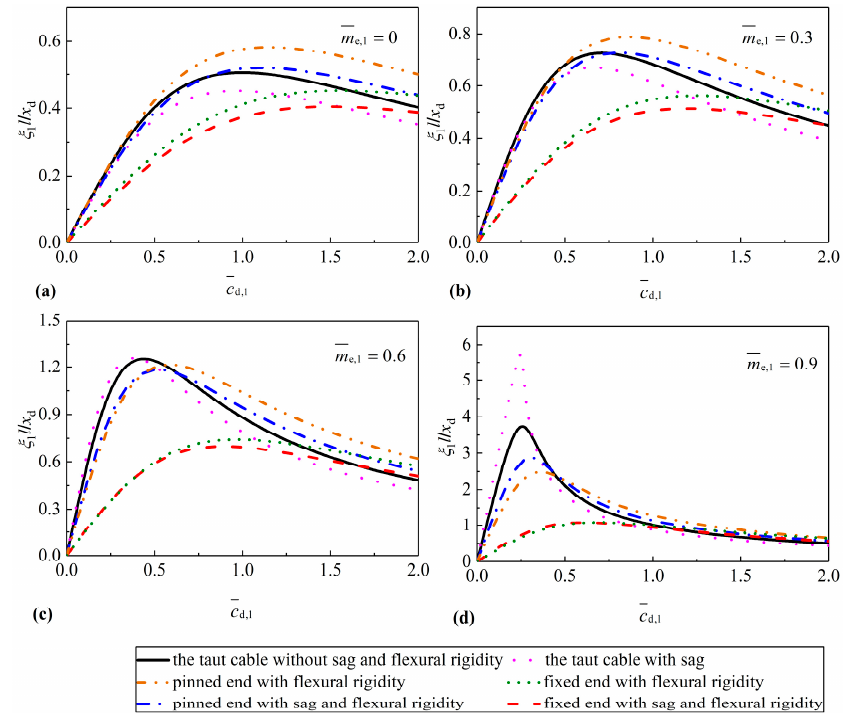
Figure 8. The first supplemental modal damping ratio of the medium cable versus damping coefficient for various inertial masses: ( a ) m e,1 = 0; ( b ) m e,1 = 0.3; ( c ) m e,1 = 0.6; ( d ) m e,1 =